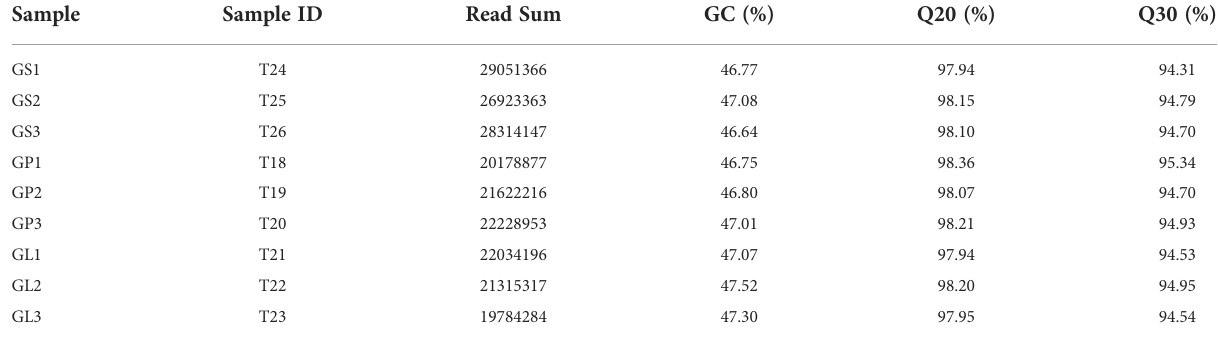
TABLE 1 Evaluation statistics of sample sequencing data.